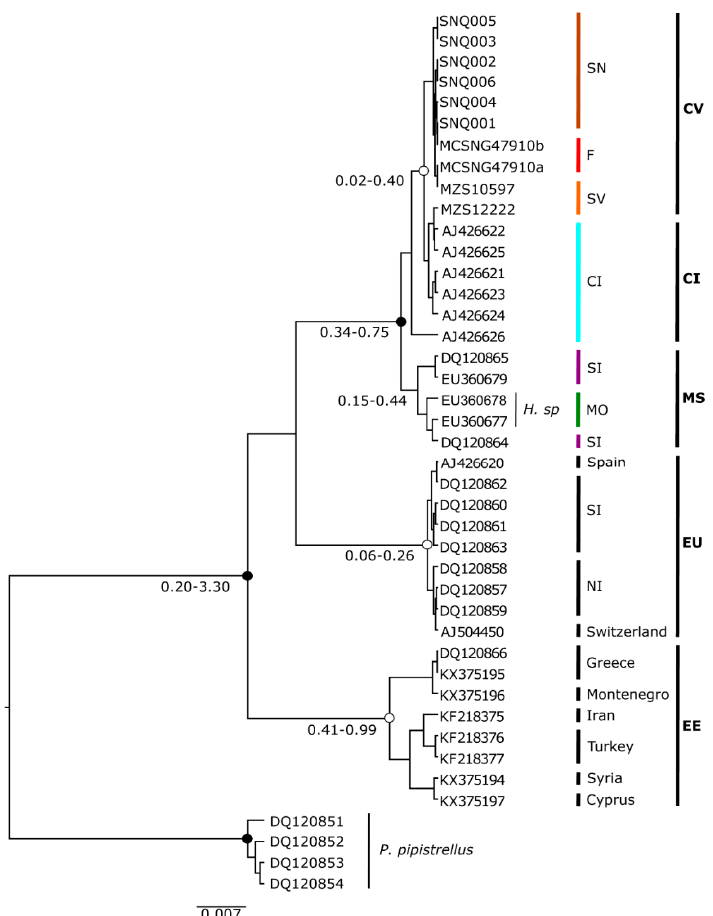
Figure 3. Phylogenetic results for Hypsugo samples from Cabo Verde based on the cyt b mtDNA sequence variation. Maximum likelihood (ML) phylogenetic tree of Hypsugo individuals rooted with P. pipistrellus (outgroup). Black dots on the nodes indicate both ML bootstraps values ≥ 70 and Bayesian inference (BI) posterior probability ≥ 0.95, while white dots show BI ≥ 0.95. The 95% highest posterior density intervals of the nodes estimated with BEAST dating analysis are indicated below the branches. Clades of Cabo Verde (CV) — São Nicolau (SN), Fogo (F) and São Vicente (SV) islands; Canary Islands (CI); Morocco and Southern Iberia (MS) — Morocco (MO) and Southern Iberia (SI); Europe (EU) — SI and Northern Iberia (NI), and Eastern Europe (EE) — are colored according to their geographic location corresponding to Figure 4. For further details on the samples, see Figure 1, and Table S1 and S3.